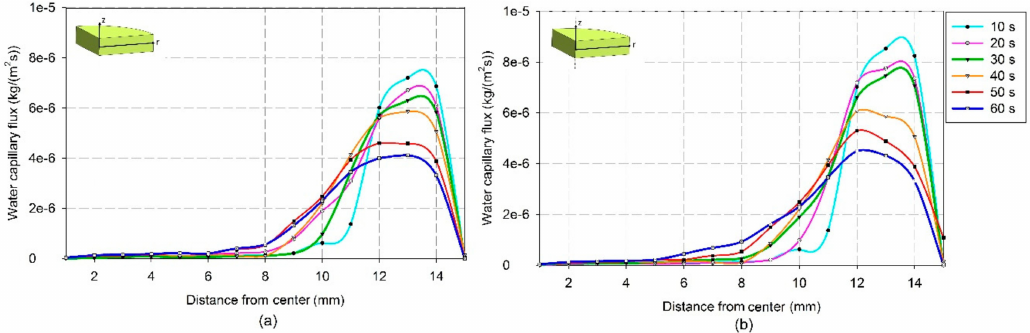
Figure 15. Water flux due to capillary of ( a ) unripe bananas, and ( b ) ripe